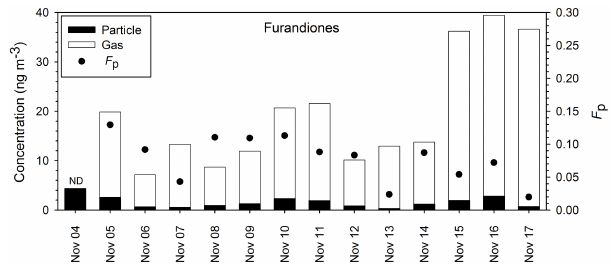
Figure 6. Time series of the measured furandiones (2,5- furandione (FD), dihydro-2,5-furandione (DFD), 3-methyl-2,5- furandione (MFD), and dihydro-3-methyl-2,5-furandione (DMFD)) detected in gas and particle phases, with the measured fraction in the particle phase ( F p ) . Furandiones were not detected in the gas phase on 4 November 2015. Due to poor extraction recoveries, the gas-phase concentration of FD was not